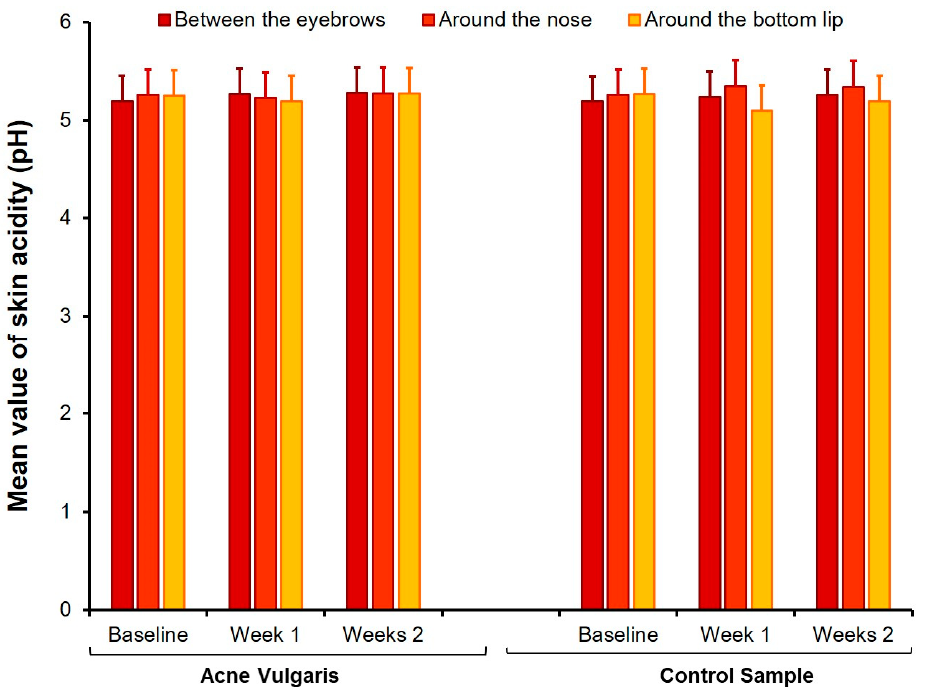
Figure 5. Comparison of mean values of skin acidity at baseline, one week, and two weeks after finishing the treatment with hydrogen purification in both AV and CS groups. Error bars are standard deviations.